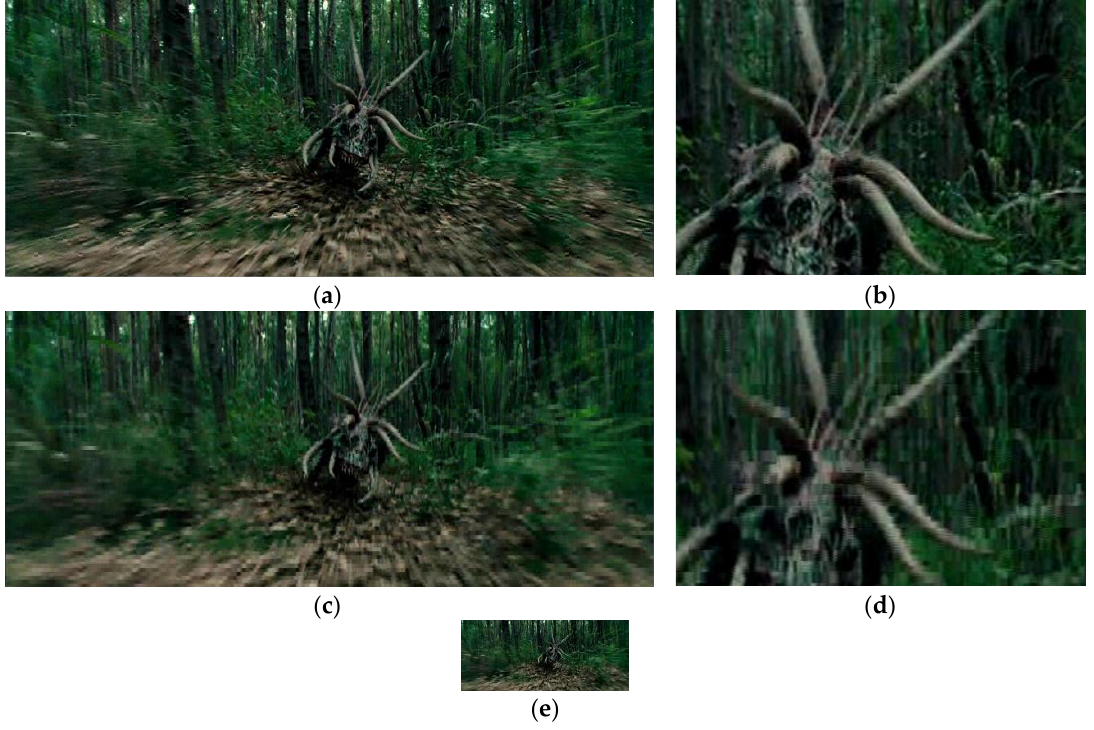
Figure 8. ( a ) A frame on a video sequence recovered after K-EM and K-DM processing, ( c ) a frame on an expired video sequence with low quality, and ( e ) a frame on an expired video sequence with both low quality and low resolution. ( b ) and ( d ) are 30% enlarged versions of ( a ) and ( c )